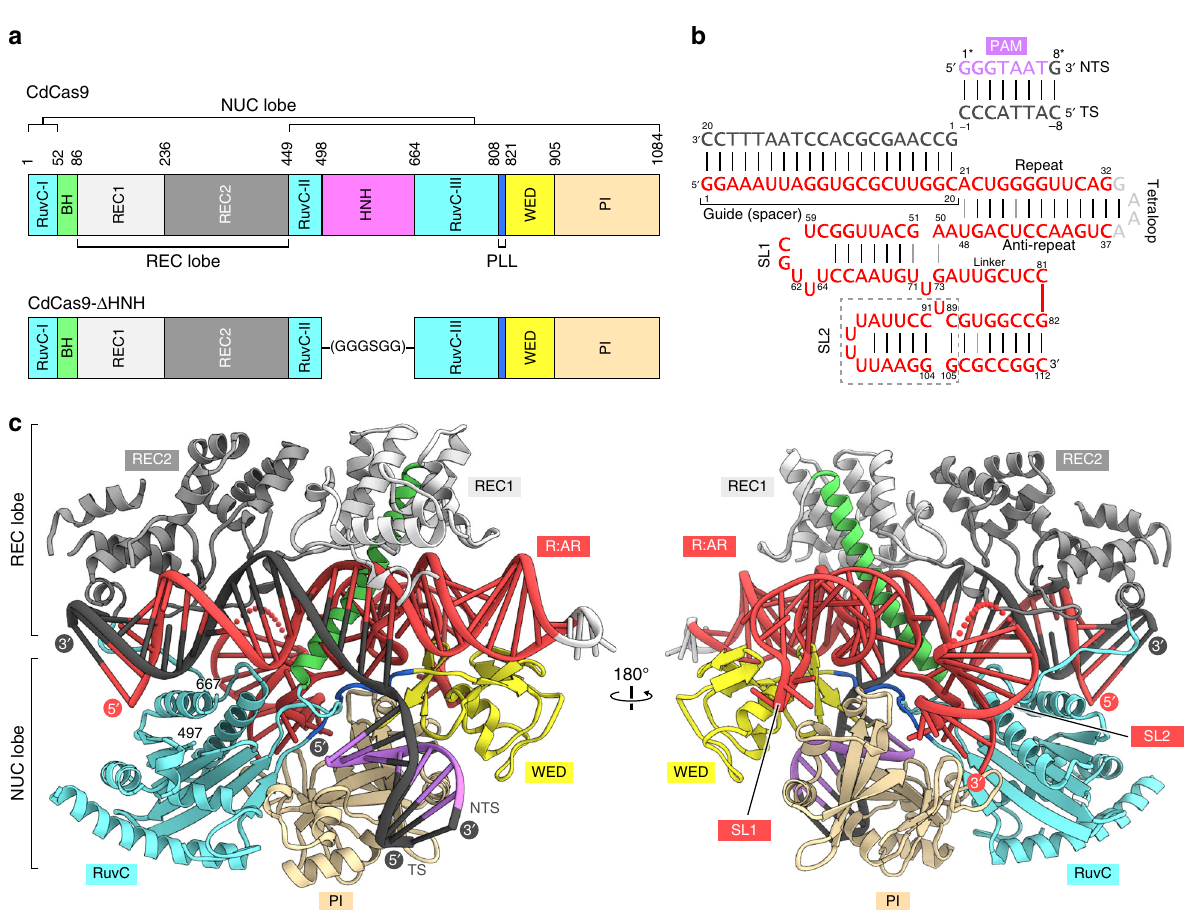
Fig. 2 Structure of the CdCas9-sgRNA-target DNA complex. a Domain structure of CdCas9. The HNH nuclease domain was truncated for crystallization. BH, bridge helix; PLL, phosphate-lock loop. b Schematics of the single-guide RNA (sgRNA) and the target DNA. The disordered region is enclosed in a dashed box. TS, target strand; NTS, non-target strand; SL1, stem loop 1; SL2, stem loop 2. c Overall structure of CdCas9- Δ HNH in complex with the sgRNA and its target DNA. The BH is colored green. The disordered region of the sgRNA is shown as a dotted line. CdCas9, Corynebacterium diphtheriae